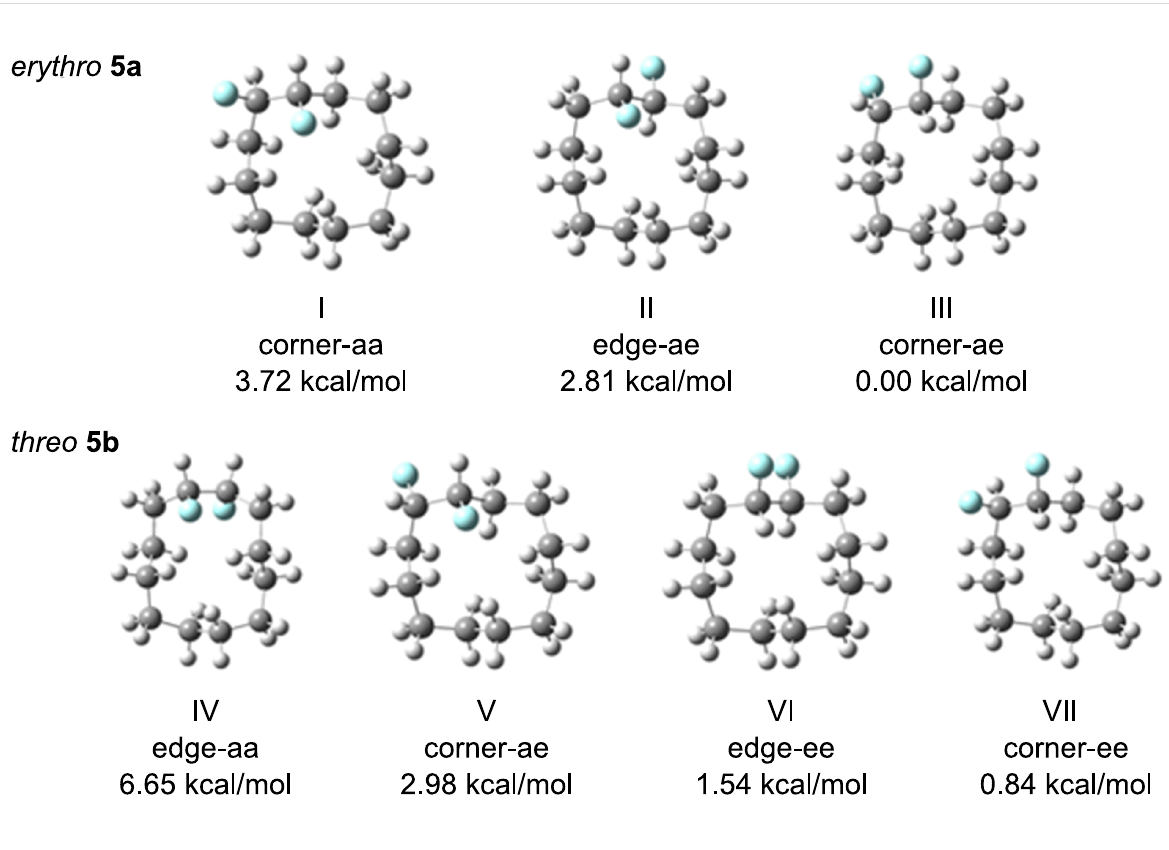
Figure 6: Calculated relative energies of the conformations of the erythro ( 5a ) and threo ( 5b ) stereoisomers of